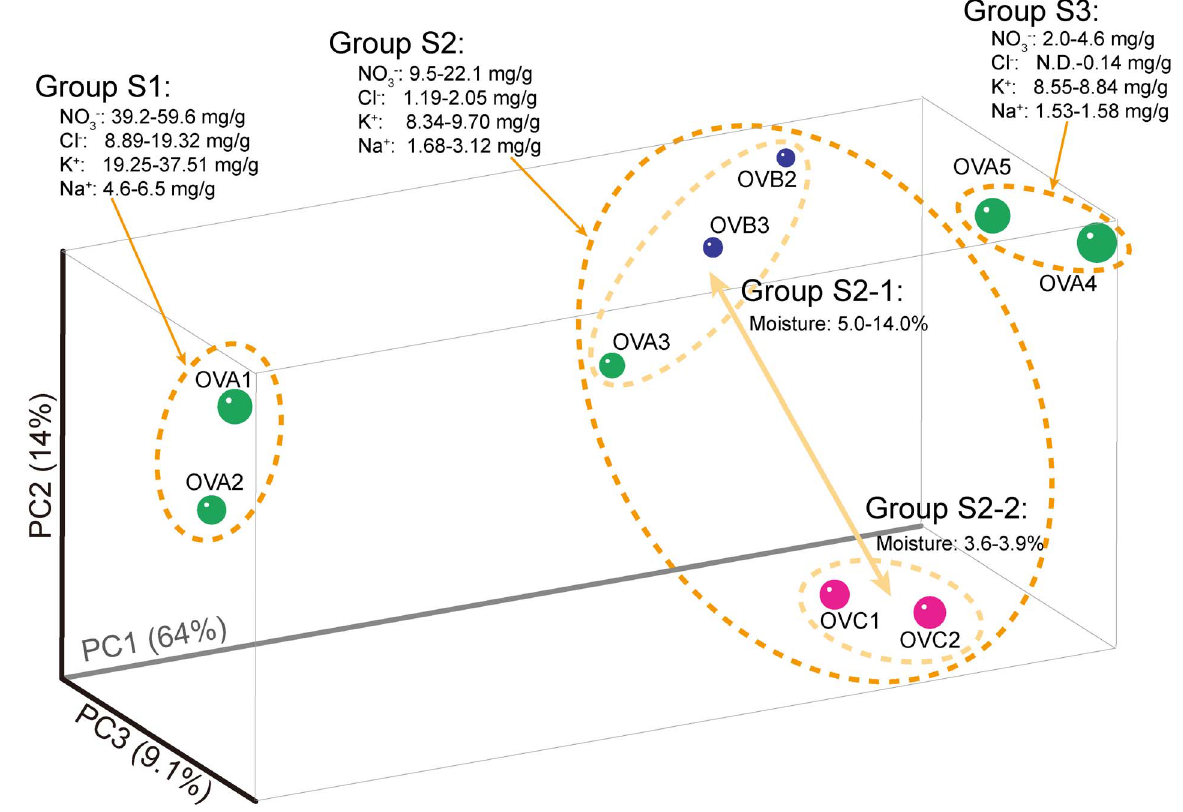
Figure 1. Principal coordinate analysis based on the abundances of 16S rRNA gene OTUs (weighted UniFrac) and separating soils according to their ion contents. For this analysis, observed 16S rRNA gene OTUs were normalized to 7,770 reads per soil.